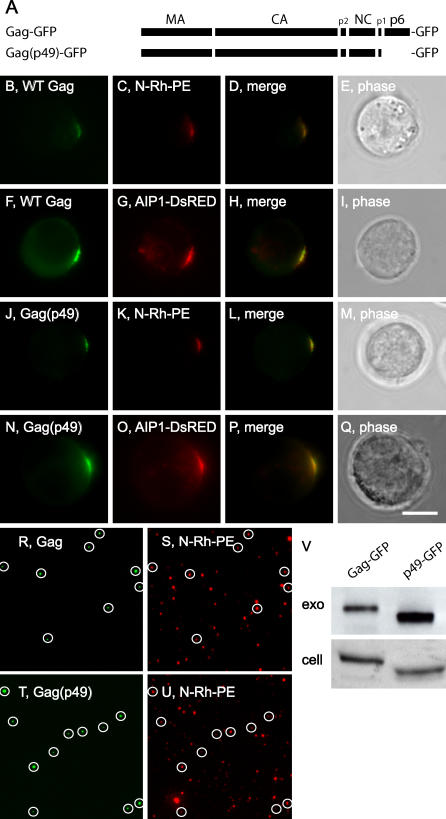
HIV Gag Is Sorted to ELDs and Exosomes Independently of Its p6 Domain(A) Line diagram of HIV Gag showing the relative positions and lengths of its MA (matrix), CA (capsid), p2, NC (nucleocapsid), p1, and p6 domains, as well as the absence of p6 from HIV Gag(p49)-GFP.(B–Q) Fluorescence micrographs of Jurkat T cells expressing (B–I) HIV Gag-GFP and (J–Q) HIV Gag(p49)-GFP, that had either been (B–E and J–M) incubated previously with the exosomal lipid N-Rh-PE or (F–I and N–Q) co-transfected with a plasmid that expresses AIP1-DsRED.(R–U) Fluorescence micrographs of exosomes collected from N-Rh-PE–labeled Jurkat T cells expressing either (R and S) HIV Gag-GFP or (T and U) HIV Gag(p49)-GFP. White circles mark exosomes that contain both N-Rh-PE and Gag-GFP or Gag(p49)-GFP.(V) Anti-Gag immunoblot of exosomes (exo) and cell lysates (cell) from Jurkat T cells expressing either (left lanes) HIV Gag-GFP or (right lanes) HIV Gag(p49)-GFP. The same ratio of exosome lysate:cell lysate was used for both samples. Bar indicate 10 μm.